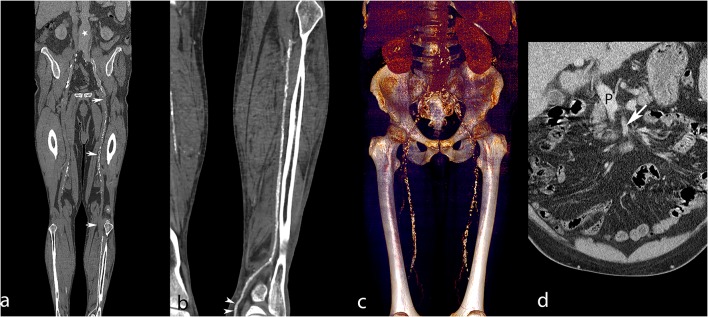
Lower extremity CT angiography obtained with the RA technique in a 65-year-old man with a history of ischemic and hypertensive heart disease, atrial fibrillation, chronic obstructive pulmonary obstruction, past stroke, and an aneurysm of the abdominal aorta. The patient was admitted for critical ischemia of the lower limbs, characterized by Fontaine stage IV disease of the left lower limb with superficial ulceration. Curvilinear reconstruction of the left aortopedal arterial system (a) shows inadequate enhancement of the abdominal aorta (white star) and absent enhancement of the superficial femoral artery due to an extended occlusion (white arrows). Curvilinear reconstruction of the left posterior tibial artery (b) shows optimal enhancement till the pedal level (white arrowheads). Volume rendering reconstruction of the abdominal aorta and femoral arteries (c) provides limited visualization of the arterial system and shows enhancement of the liver and kidneys related to venous contamination. Coronally reformatted slice through the abdomen (d) shows enhanced portal vein (P) and insufficiently enhanced superior mesenteric artery (white arrow), meaning that the sampling instant was too late for arterial phase imaging. Attenuation measurements were as follows: aortic level, 99 HU; iliac level, 85 HU (right) and 94 HU (left); femoral level, 123 HU (right), and 168 HU (left); tibial level 270 HU (right), and 305 HU (left); pedal level, 235 HU (right), and 273 (left). HU, Hounsfield units.